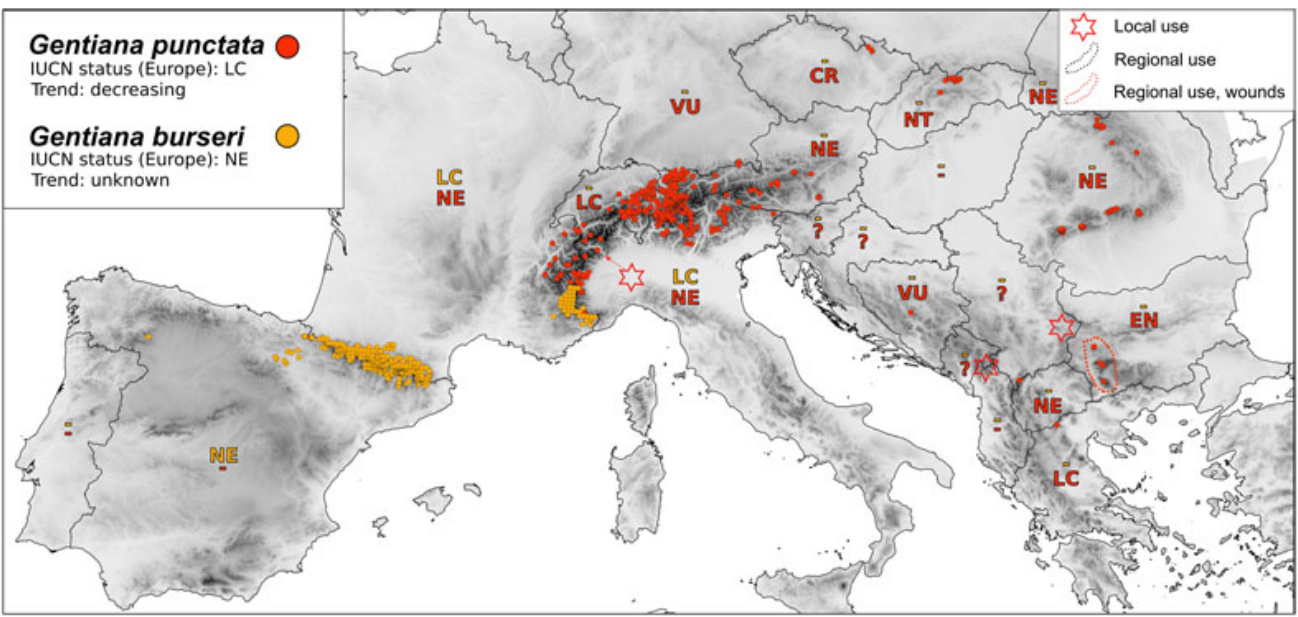
Figure 3. Map of distribution G. punctata and G. burseri— conservation status and medicinal use, Legend: IUCN status—Least Concern (LC); Near Threatened (NT); Vulnerable (VU); Endangered (EN); Critically Endangered (CR); and Not Evaluated (NE).